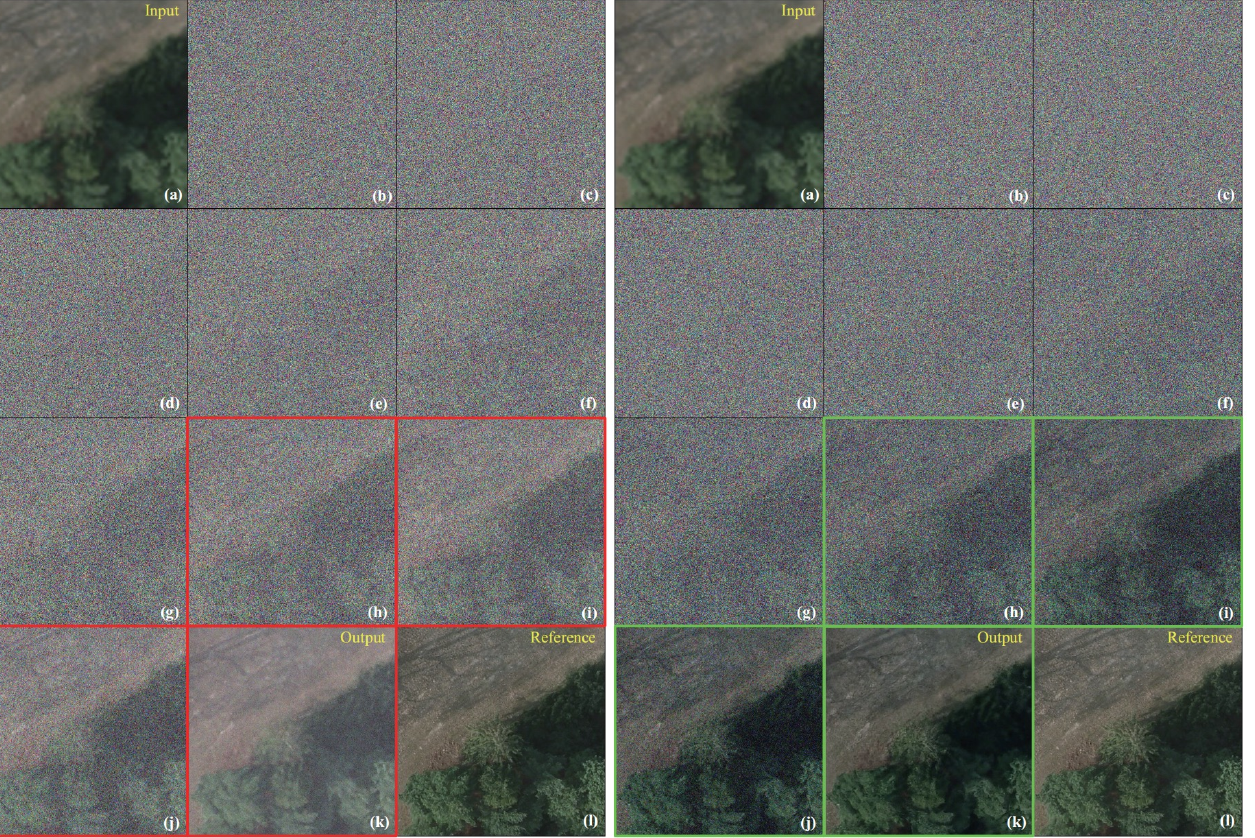
Figure 7. RSSR reconstruction visualization results of DMDC images with and without pixel con- straint loss, with no pixel constraint loss ( left ) and pixel constraint loss ( right ). ( a : input) the input image. ( b – j ) the results of the image reconstruction process. ( k : output) image reconstruction results. ( l : reference) tag. Zoom-in for better